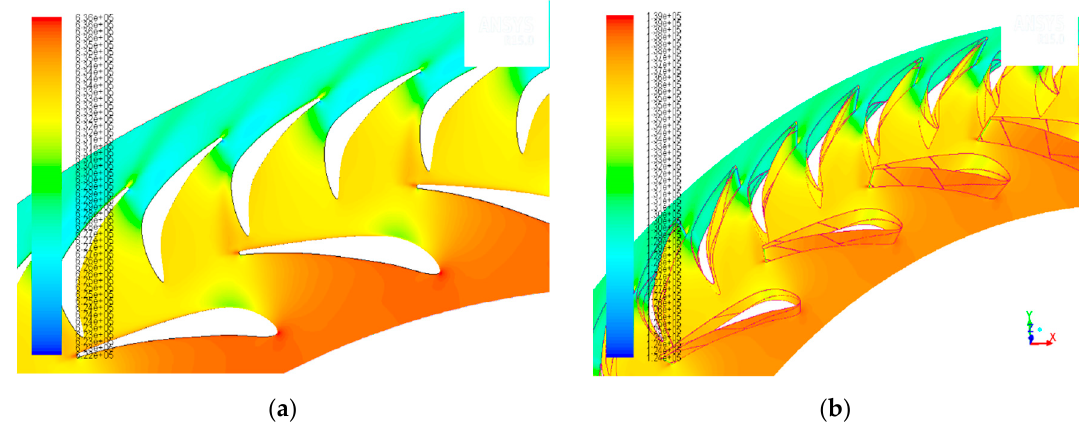
Figure 15. Contours of static enthalpy for a single time step: ( a ) 2D model; ( b ) 3D model.